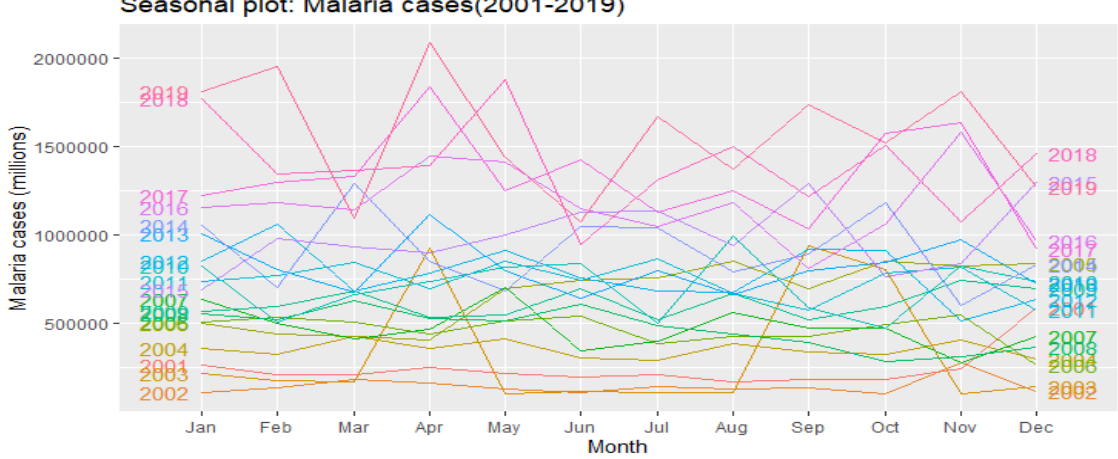
Figure 10. Seasonality of malaria episodes in DRC from 2001 to 2019.